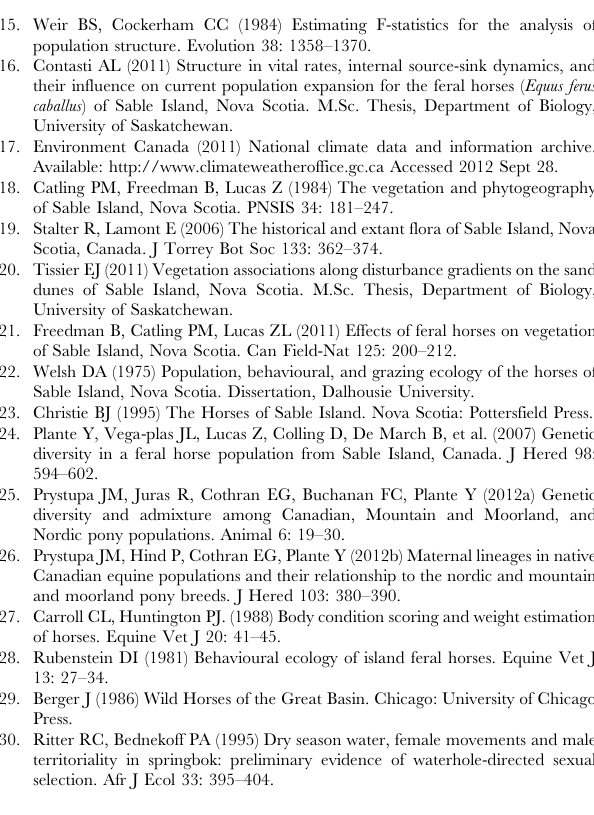
Average local density a (no. females